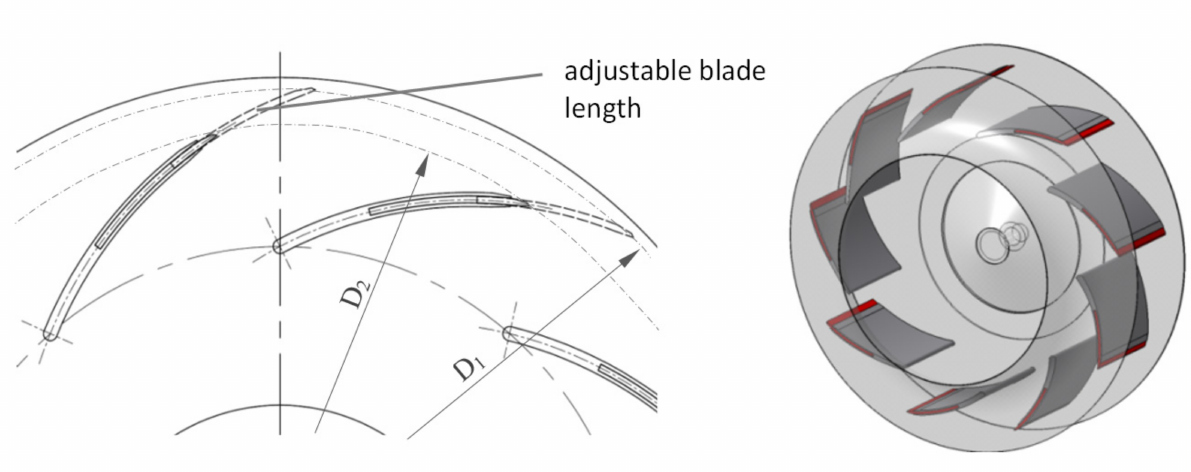
Figure 1. Impeller with variable blade